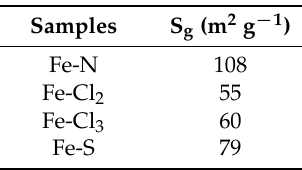
Table 3. Surface area (S g ) of carbon-based nanomaterials from kraft lignin promoted with different iron catalysts.